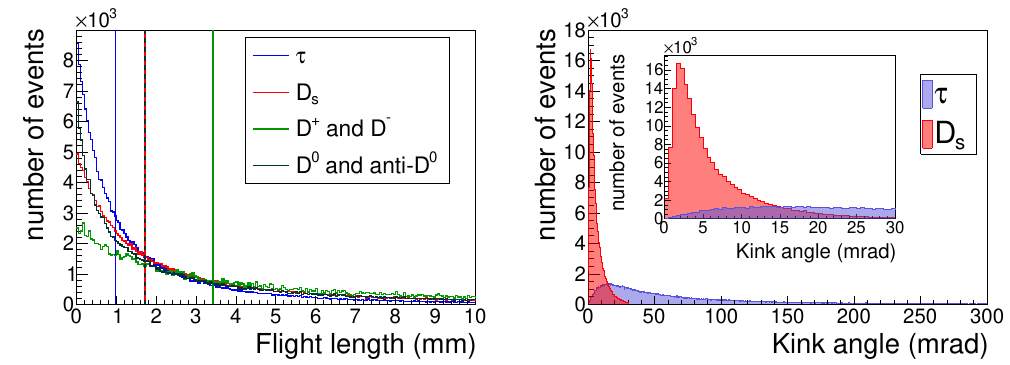
Figure 3 . Expected distributions of (cid:13)ight length (left) and kink angle (right) of charmed particles and (cid:28) . In the left plot, the median of each (cid:13)ight length is indicated as a vertical line. (mean kink angle of 96 mrad), the kink angle at D ! (cid:28) decays is rather small, 6.2 mrad on s average. The measurement of D momentum is also di(cid:14)cult as two (cid:23) escape s (cid:28)